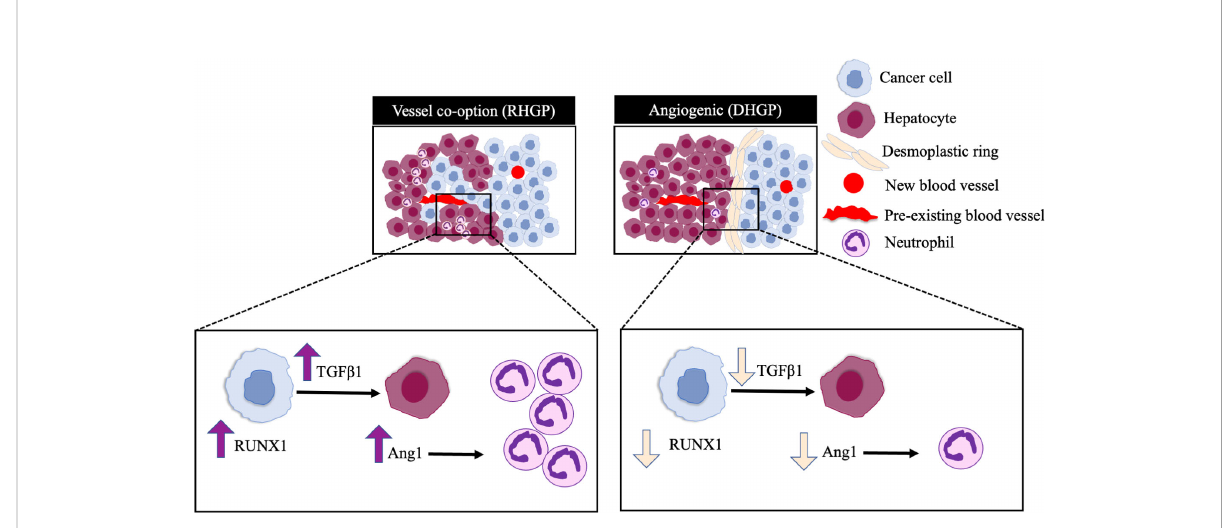
FIGURE 5 Schematic representation of the pathways involved in neutrophil in fi ltration in CRCLM. RUNX1 is highly expressed in the cancer cells of vessel co-opting CRCLM lesions compared to angiogenic lesions, which induces the expression of TGF b 1 and Ang1 in the neighbouring liver parenchyma. The overexpression of Ang1 incites the migration of neutrophils into the tumour microenvironment.